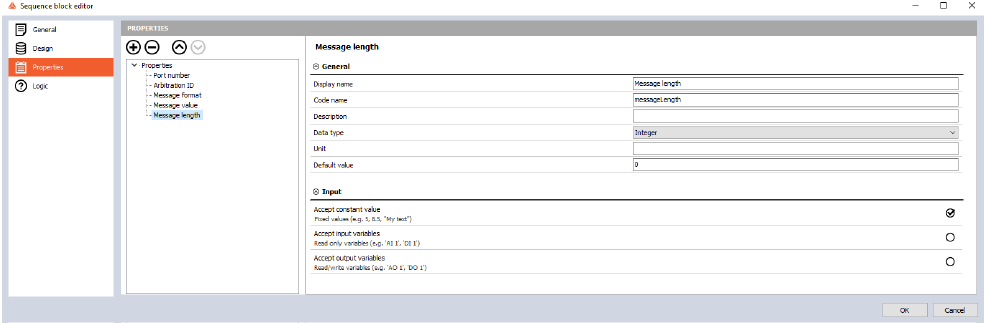
Figure 8. Advanced end-user perspective on visual block properties